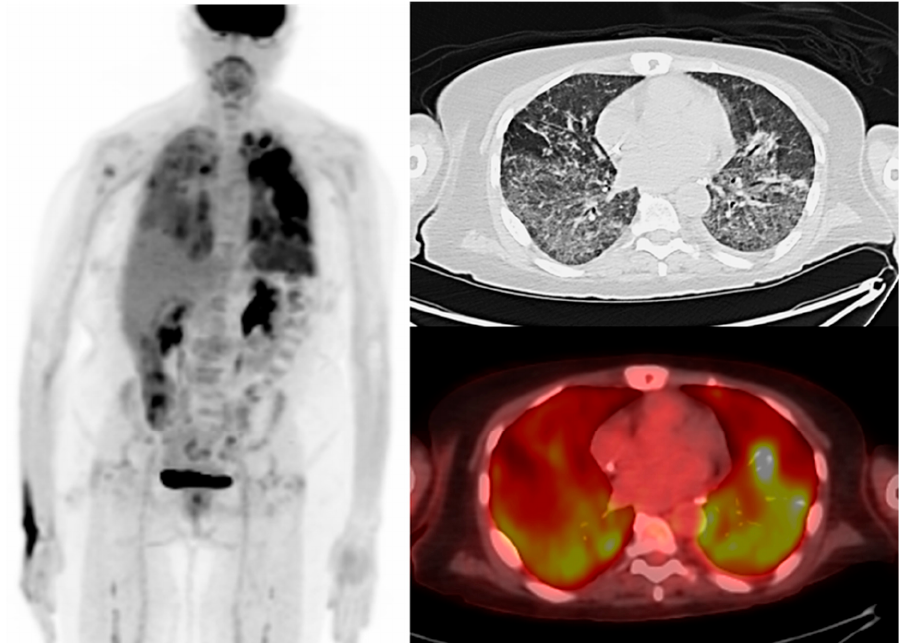
Figure 5. A 65-year-old man with relapsed multiple myeloma. Maximum intensity projection, axial CT, and fused PET/CT showing diffuse bilateral FDG-avid ground-glass pulmonary opacities and interlobular septal thickening, greater in the lower lobes on FDG PET/CT obtained post-CAR T-cell therapy suspicious for pneumonitis in the context of cytokine release syndrome. Diagnostics 2023 , 13 , x FOR PEER REVIEW